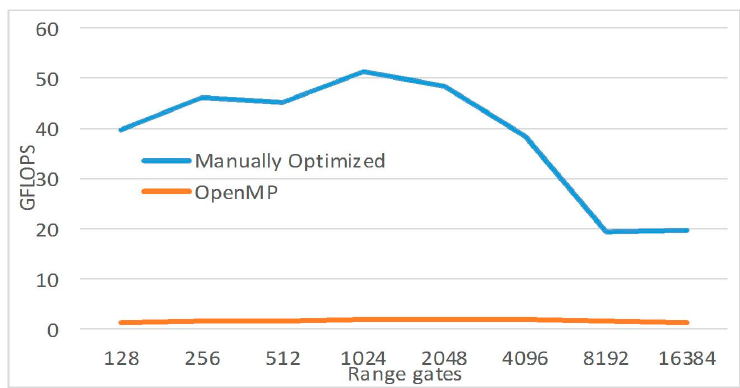
Figure 18. Comparing OpenCL performance to manually optimized code for pulse compression.